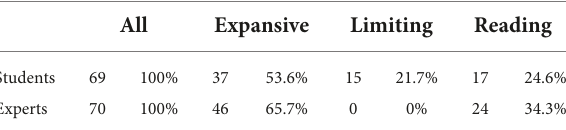
TABLE 2 Applied